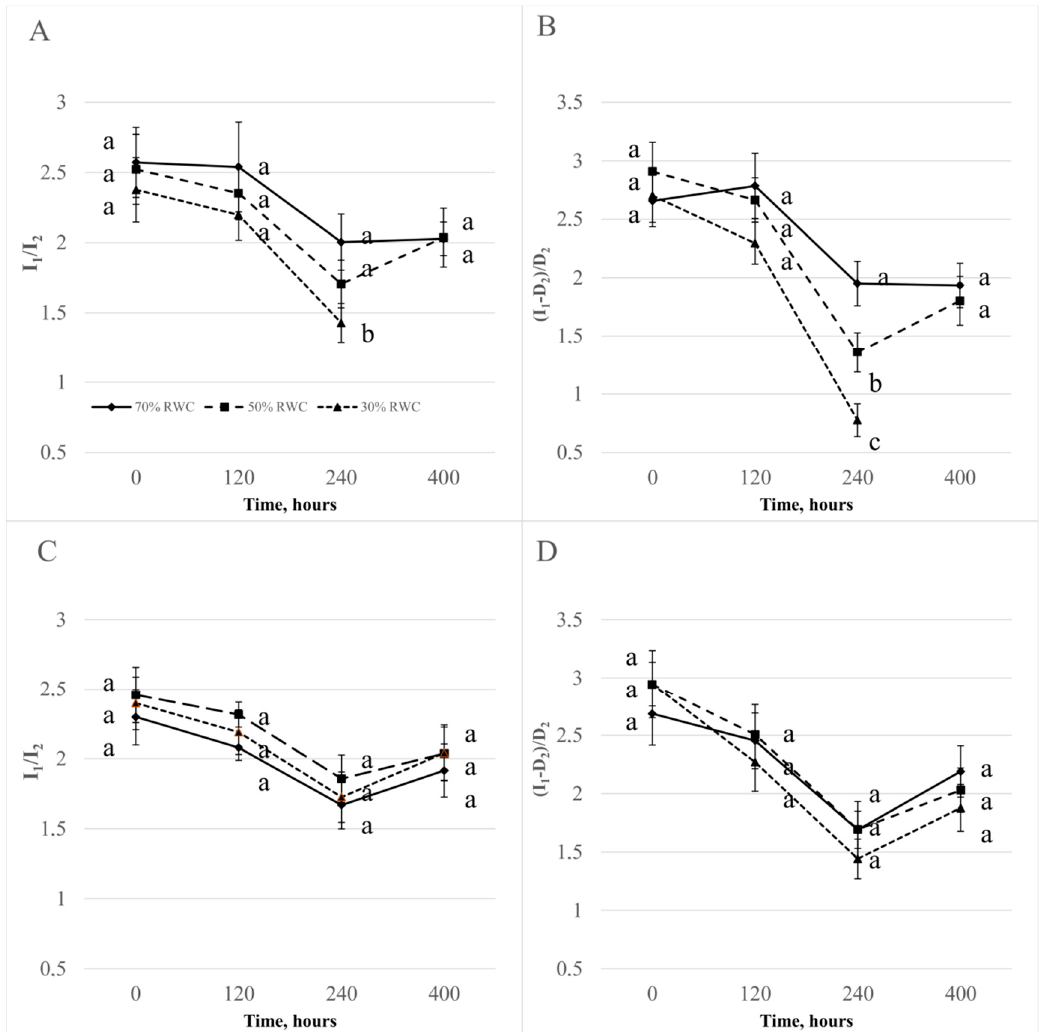
Figure 5. (I 1 -D 2 ) / D 2 and I 1 / I 2 ratios ± S.D. of perennial ryegrass varieties (Roadrunner and Nira) under different field water capacities of soil (50 and 30% FWC) and times (0, 120, 240, and 400 h after stress application): ( A ) Roadrunner under 50% FWC, ( B ) Roadrunner under 30% FWC, ( C ) Nira under 50% FWC, ( D ) Nira under 30% FWC. n = 6. Relative units. Mean values within a term marked by the same letter did not show significant differences ( p < 0.05, n = 6).